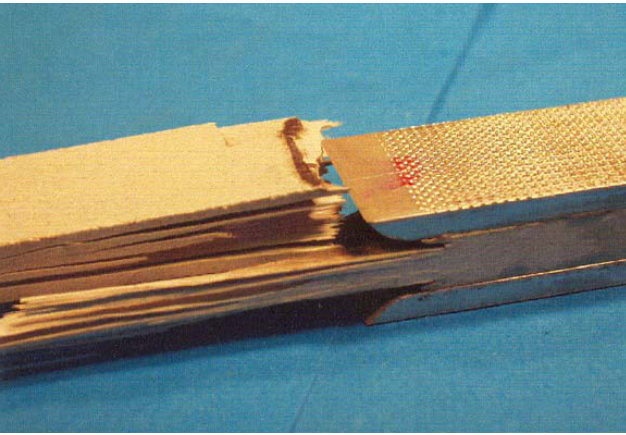
Figure 9: A fatigue broken specimen near the gripping zone.